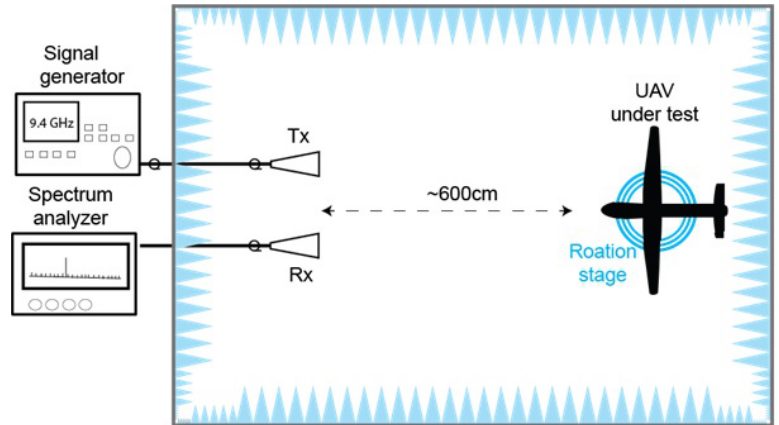
Figure 5. Radar cross-section measurement setup in anechoic